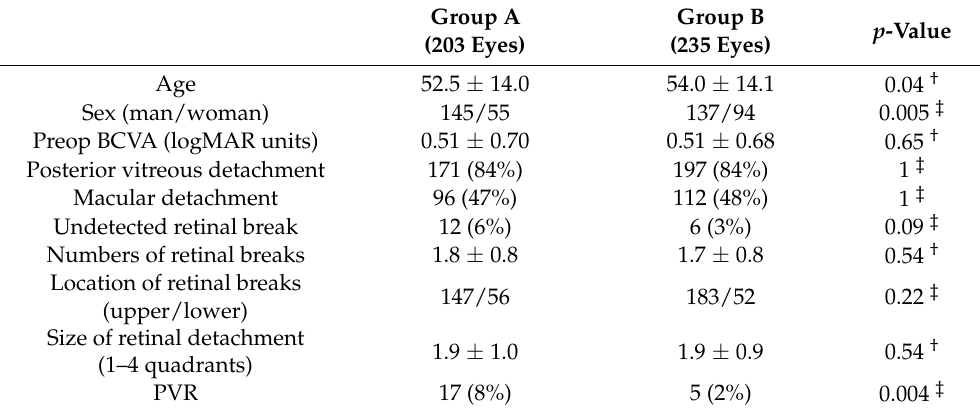
Table 1. Preoperative